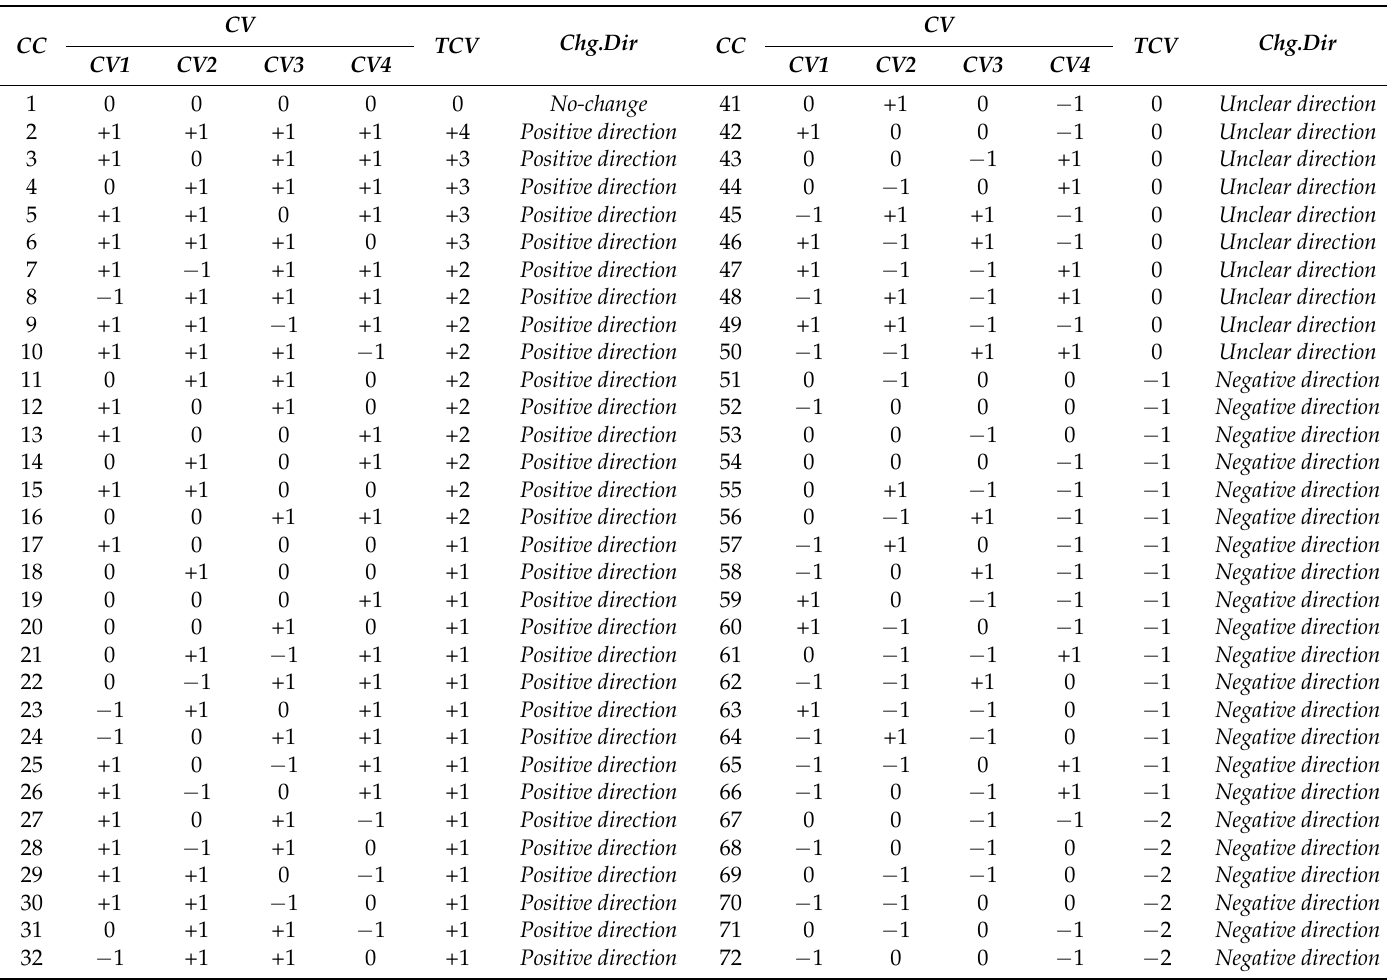
Table 3. The procedure to estimate change directions of shoreline. It quantifies the variation of water membership in each pixel and shows how frequent the changes have